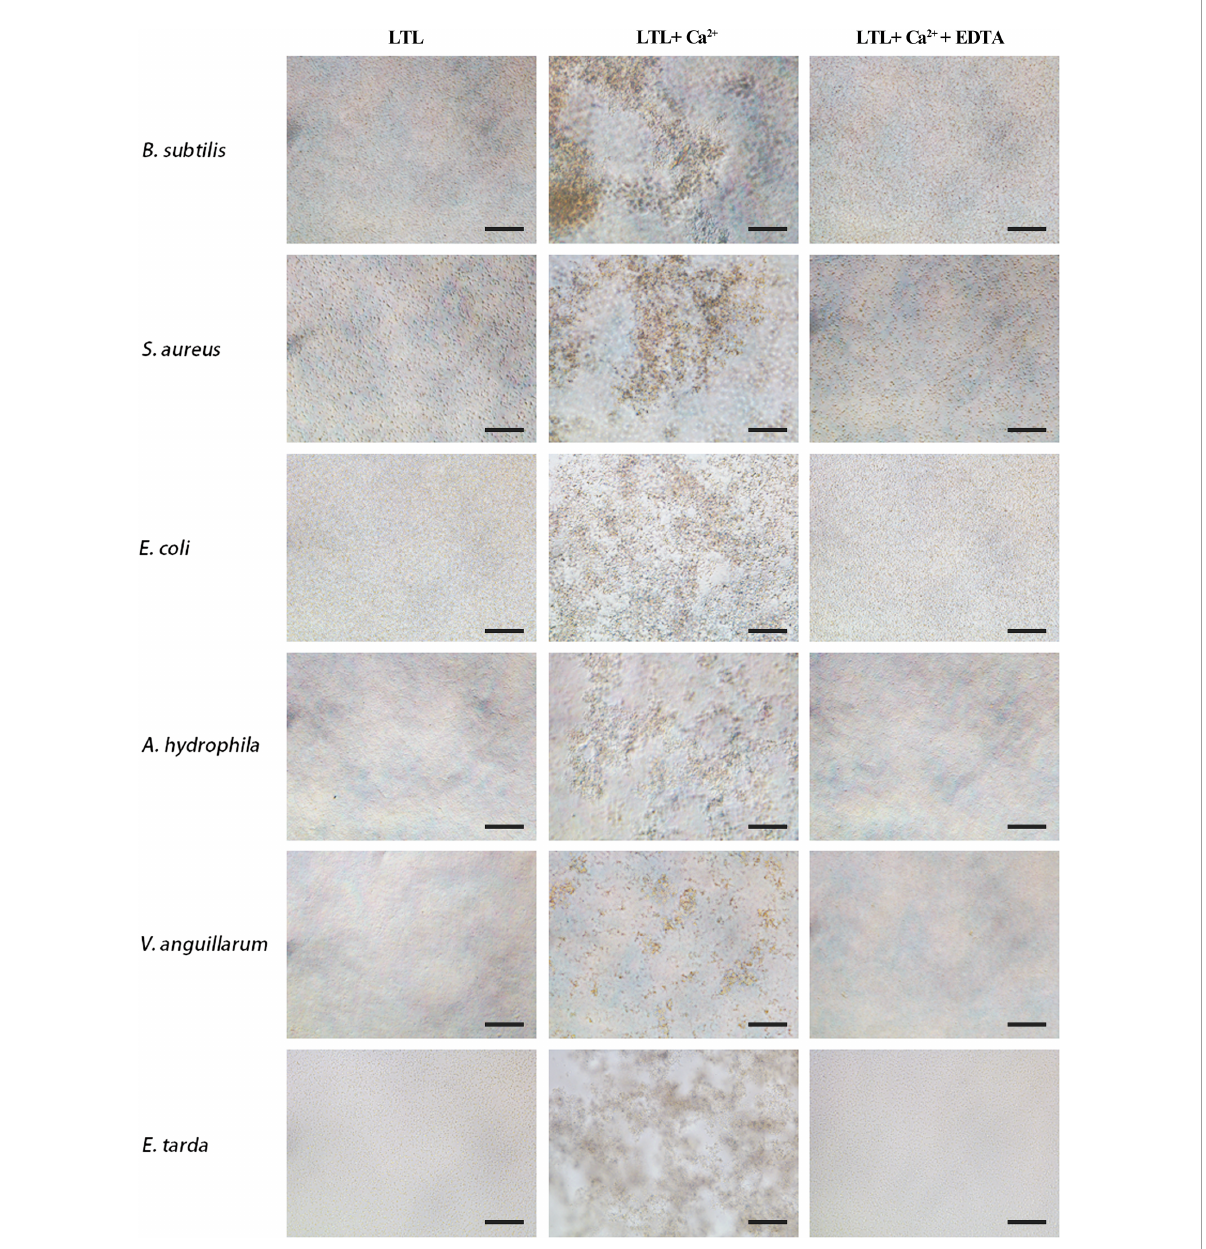
FIGURE 4 Agglutination activity of rOppLTL to bacteria. B.subtilis , S. aureus , E coli , V. anguillarum , E tarda , and A. hydrophila were incubated with rOppLTL in the absence or presence of Ca 2+ . The cells were observed with a microscope. Bar: 10 m